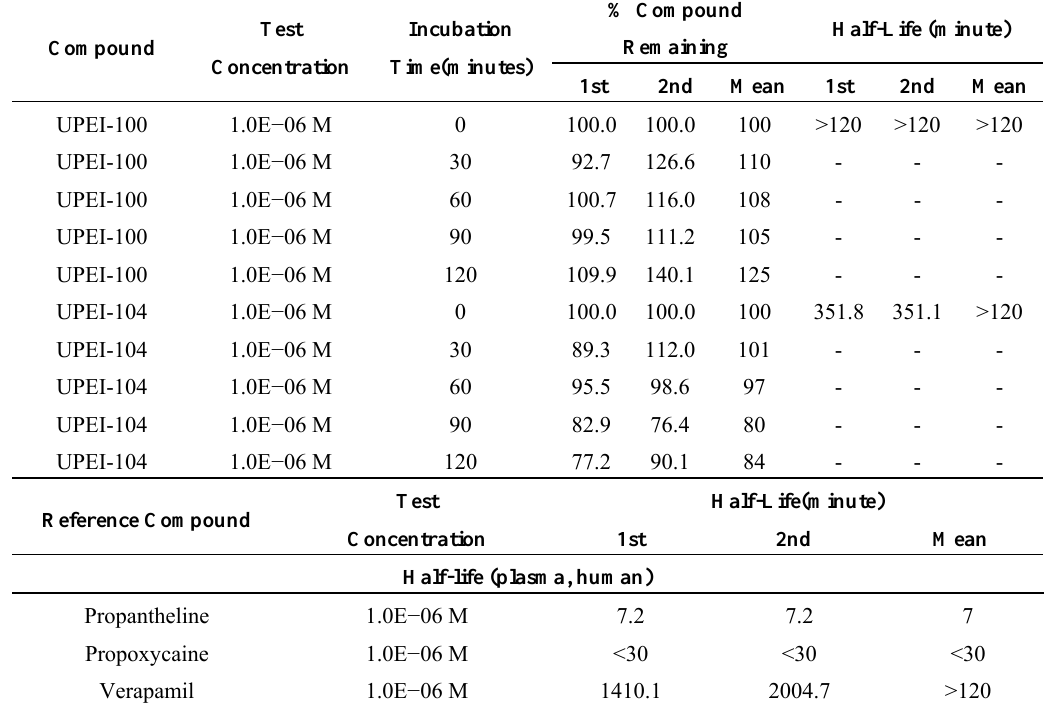
Table 2. Metabolic stability of UPEI-104 and UPEI-100 in human plasma.